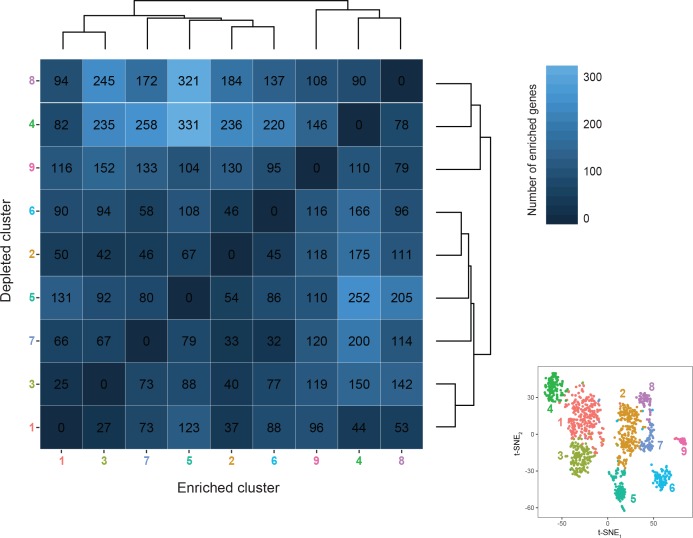
Hierarchical organization and differentially expressed genes.For each pairwise comparison across clusters, the number of enriched genes (defined as >3 fold enriched on average between the ‘enriched’ cluster relative to the ‘depleted’ cluster and pADJ <0.05) is shown. Matrix is ordered relative to hierarchical relationship of transcriptomes. For reference, t-SNE visualization of clustered transcriptomes is provided.